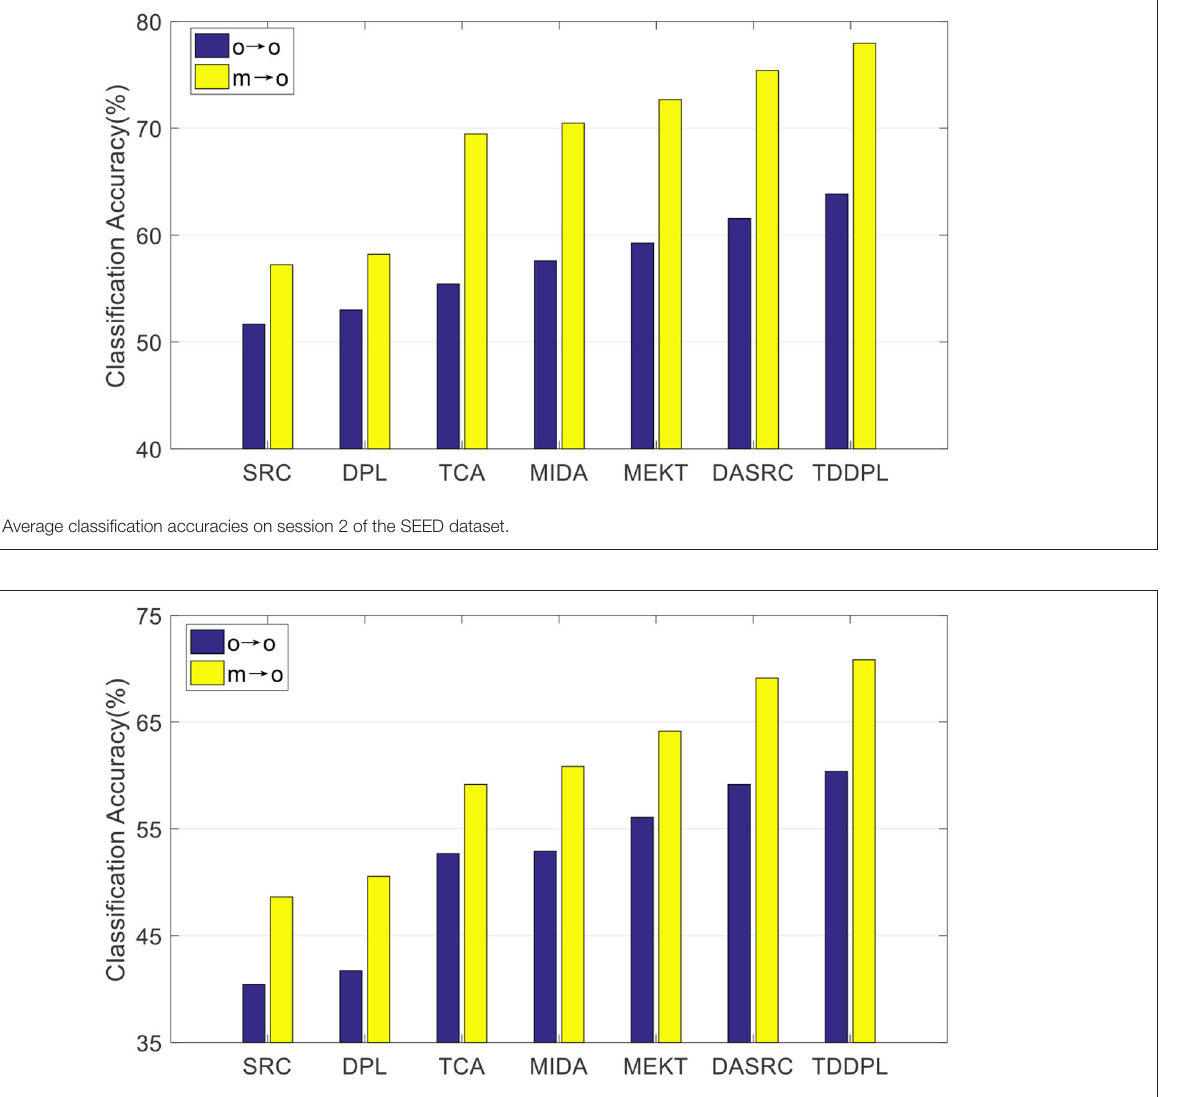
FIGURE 2 | Average classification accuracies on session 3 of the SEED